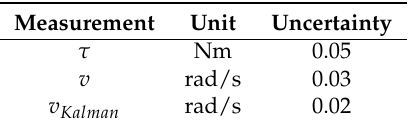
Table 5. Uncertainty on torque and velocity